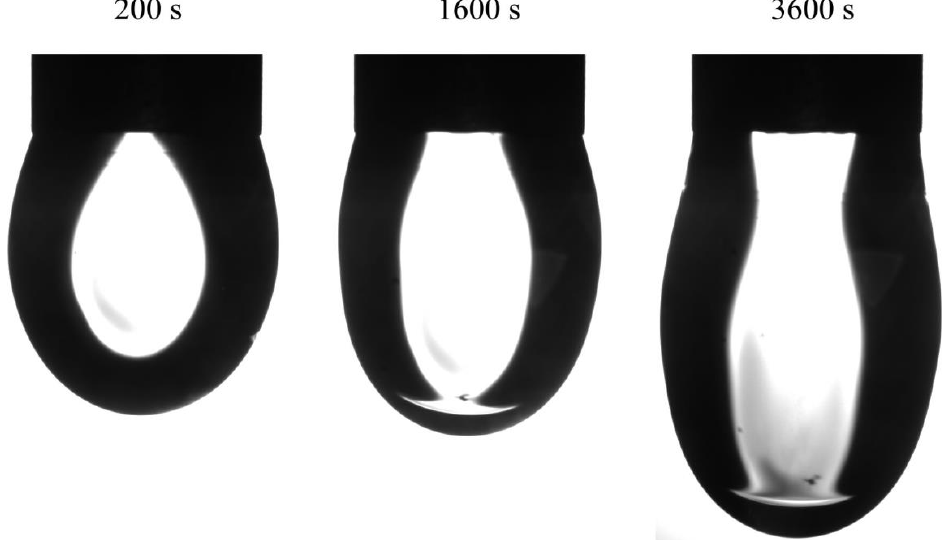
Figure 5. Images of water drops with initial volume of 15 mm 3 in hexane vapor at 200, 1600 and 3600 s from the start of the experiment. In the images taken after 1600 and 3600 s the hexane phase is clearly seen in the lower part of the drop.